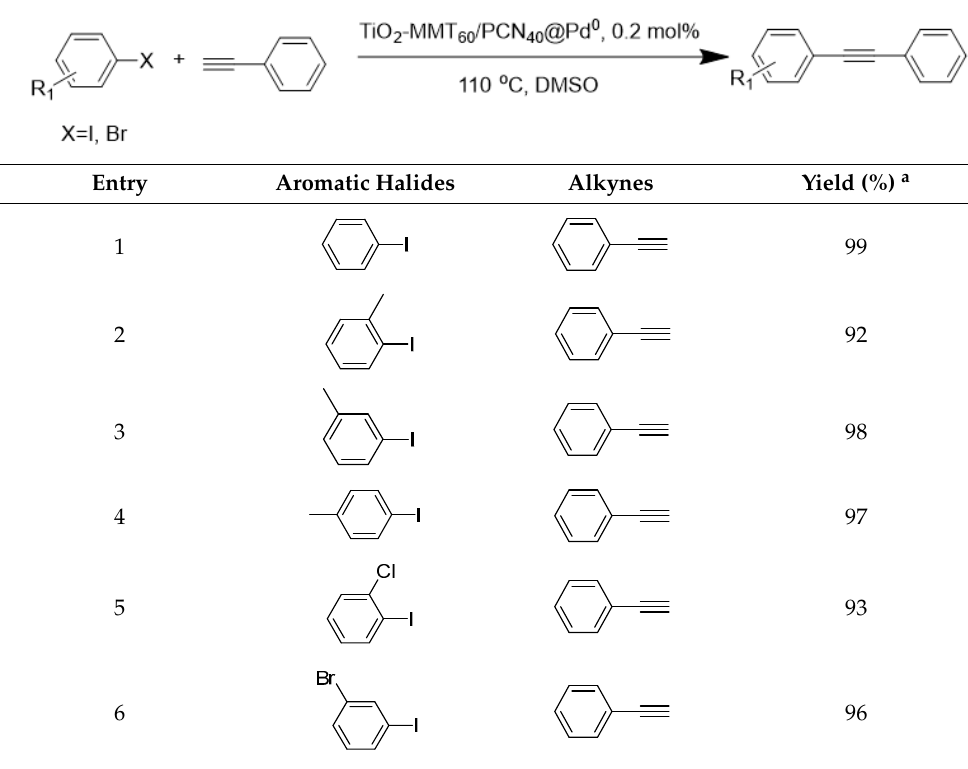
coupling reactions between aromatic halides and